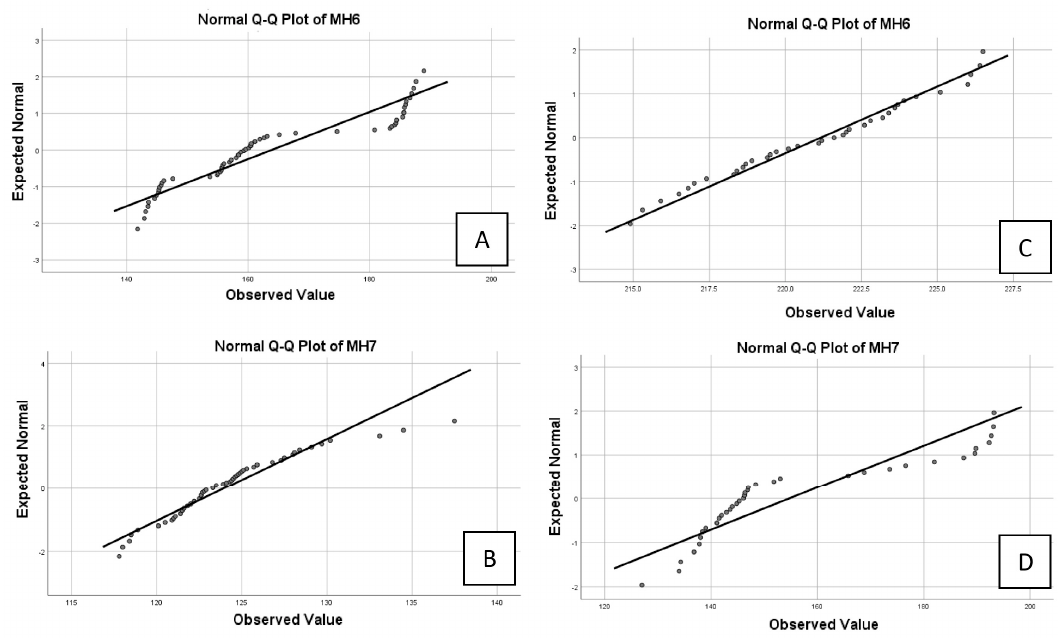
Figure 9. Normality plots for ( A ) manhole 6 during 20 August–22 October 2018, ( B ) manhole 7 during